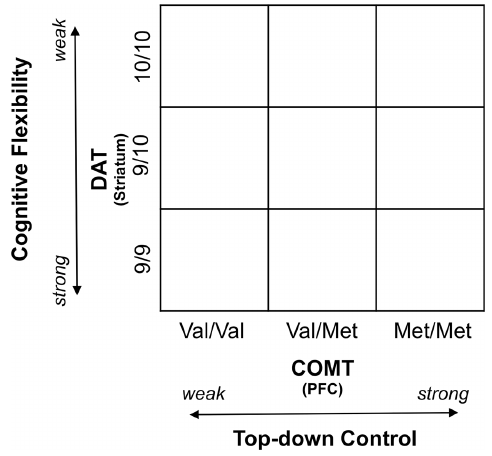
Fig 1. Putative associations between COMT (tied to DA availability in the prefrontal DA pathways) and top-down cognitive control; and DAT (tied to DA availability in striatal pathways) and cognitive